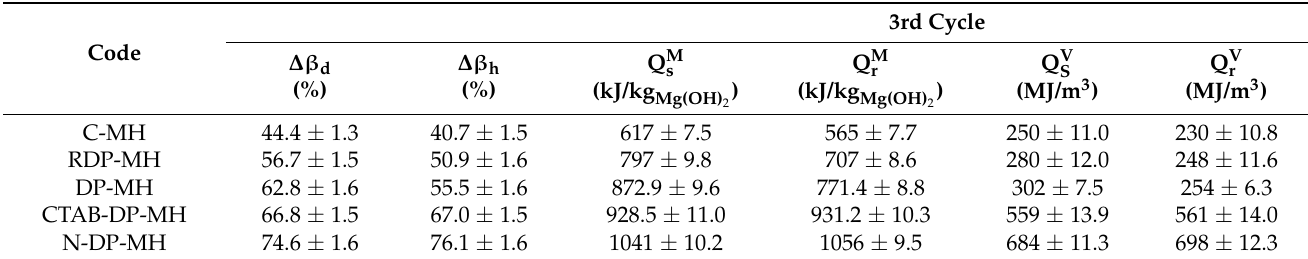
Table 3. Dehydration/hydration conversions ( ∆ β d/h ) and stored and released heat per mass unit (Q M (Q V ) at the third s/r